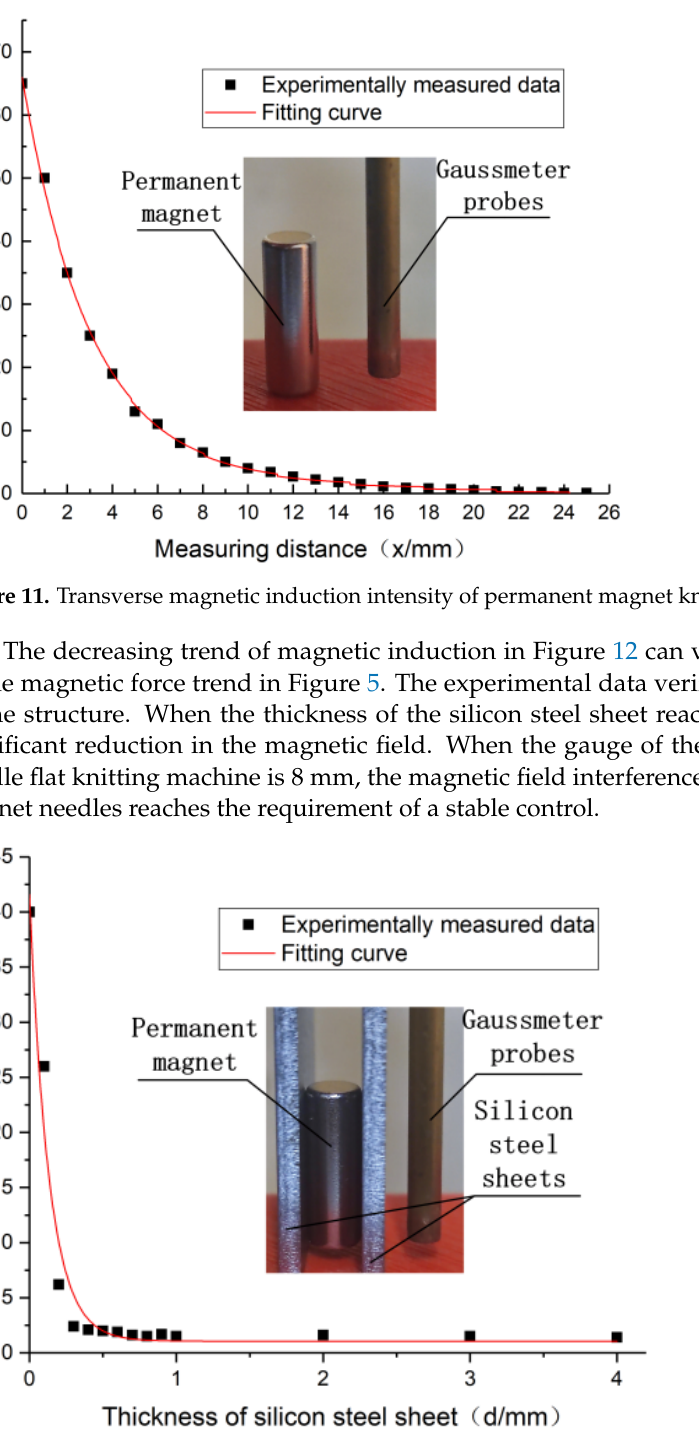
Figure 12. Variation curve of magnetic induction intensity with silicon steel thickness.